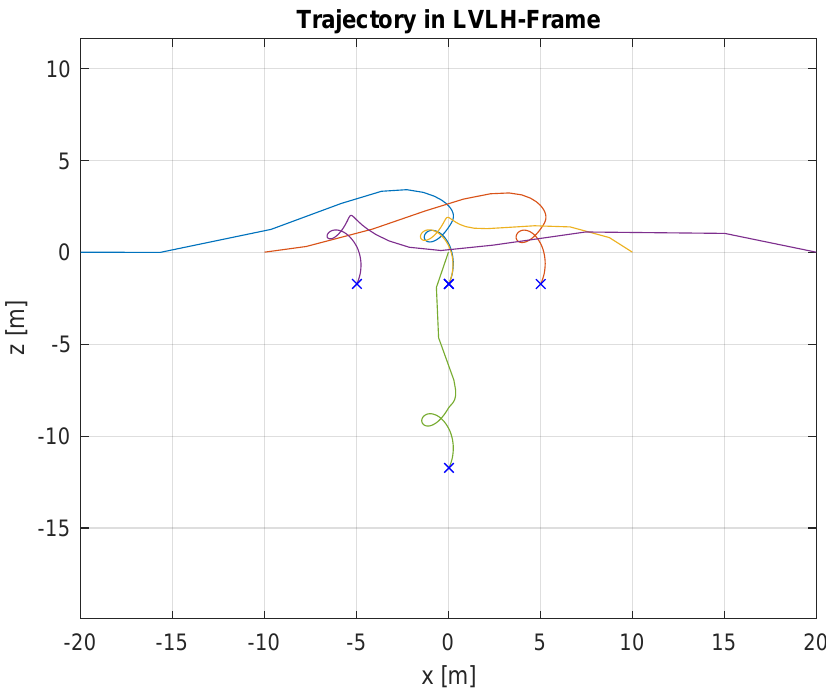
Figure 14. The x–z motion of the trajectories of the five satellites subject to the presented